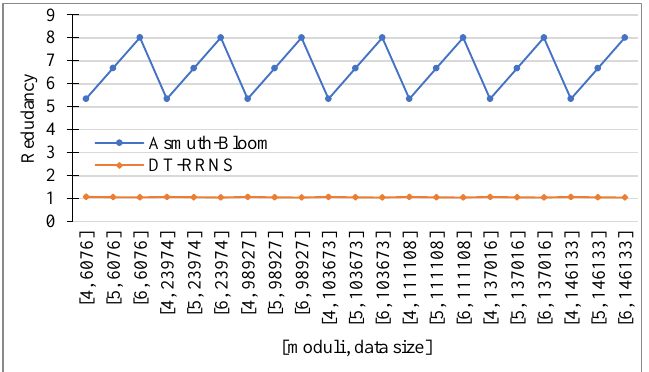
Figure 8. Redundancy. Figure 8.